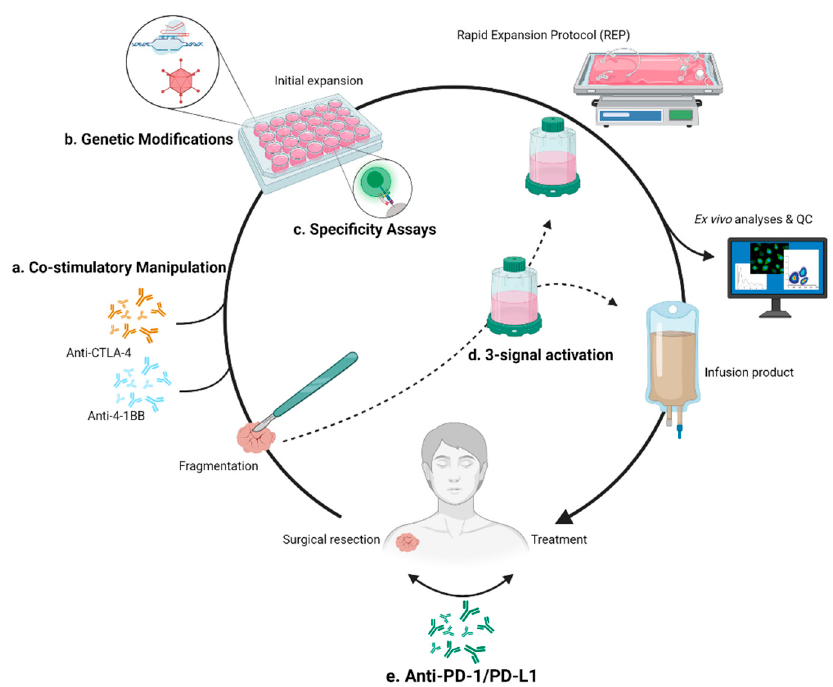
Figure 2. Modifications of TIL-based ACT workflow. ( a ) Addition of monoclonal antibodies targeting CTLA-4 and 4-1BB to improve the initial expansion phase of the workflow. ( b ) Genetic modification of TIL via CRISPR/Cas9 or viral transduction to strategically knockout or knock-in desired elements. ( c ) Identification of tumor-specific TILs to improve cancer-directed response. ( d ) A 3-signal activation method described by MDACC. Replaces initial expansion phase, and possibly could be used to bypass REP. ( e ) Priming and/or combination checkpoint inhibition therapies.